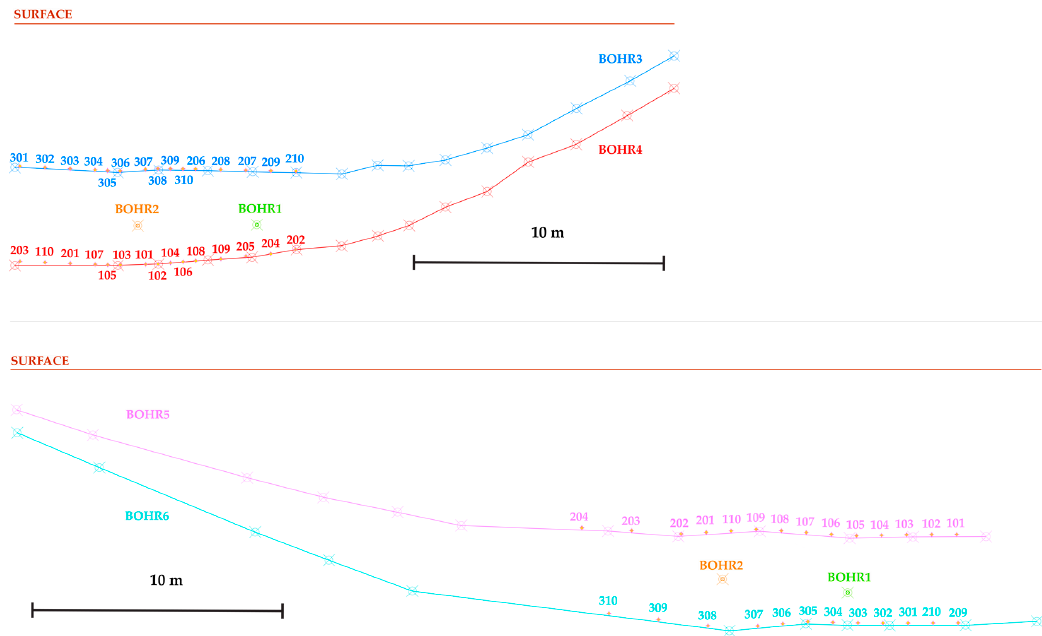
Figure 6. Profiles of BOHR3–BOHR6 with temperature sensors relative to BOHR1 and BOHR2. BOHR1 and BOHR2 enclosed high-density polyethylene pipes used for different pur- poses. The heated borehole (BOHR2) contained two pipes: a coaxial pipe containing the heat transfer fluid (HTF) (red and blue), and a regular pipe used for measuring tempera- ture (green). The parallel measurement borehole (BOHR1) was cased in a 200 mm-diam- eter pipe with a second pipe for housing the temperature sensors. All air space in both the borehole (BOHR2) and pipe (BOHR1) were filled with bentonite (gray). Pipe walls are shown in dark gray. Dimensions of the pipes are shown in Figure 7. The coaxial inner pipe (blue) and annulus (red) had wall thicknesses of 4 mm and 5.8 mm, respectively. Both measurement conduits (green) had wall thicknesses of 5.8 mm, while the 200 mm pipe in BOHR1 had a wall thickness of 18.2 mm. The spacing between BOHR1 and BOHR2 ranged between 2 and 5 m drilled to a depth of ~2.5 to ~8.5 m.